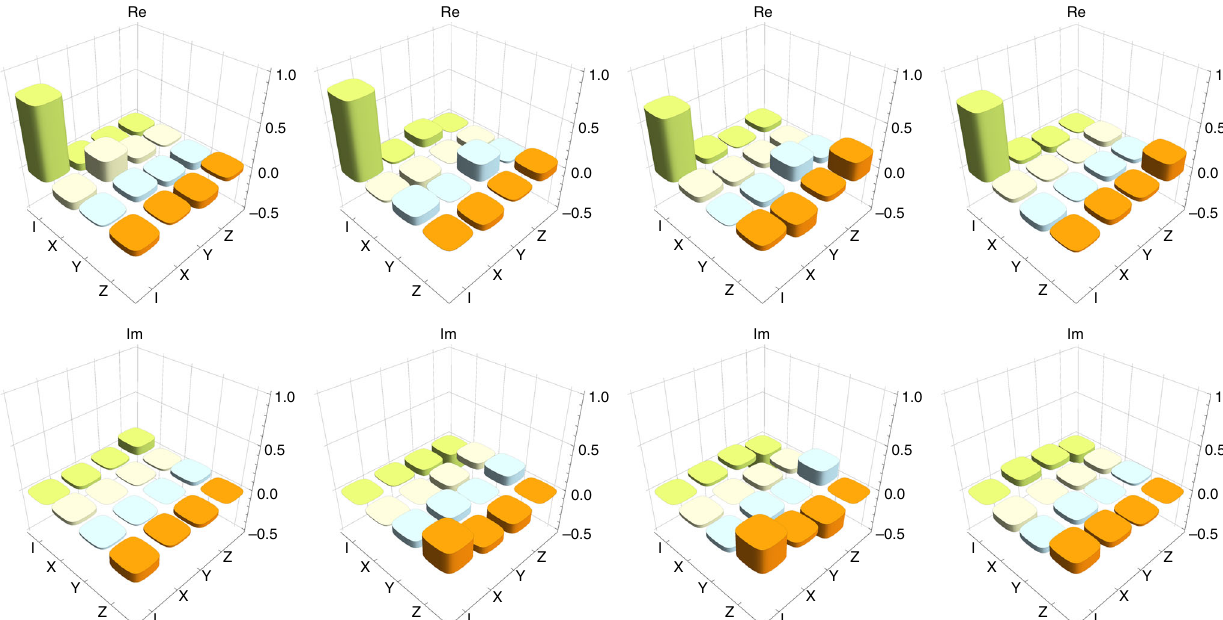
Fig. 5 The reconstructed process matrices. From the left, the matrices are estimated in the cases of the coincidence detections among D 21 and D 22 and D 11 , D D D D D D D D D 21 and 22 and 12 , 21 and 11 and 12 , and 22 and 11 and 12 from the left. Upper and lower graphs show the real and imaginary part of the process matrixes. All process matrices have a large element corresponds to the identity operation, showing high fi delities of the performed quantum teleportation, as listed in Table